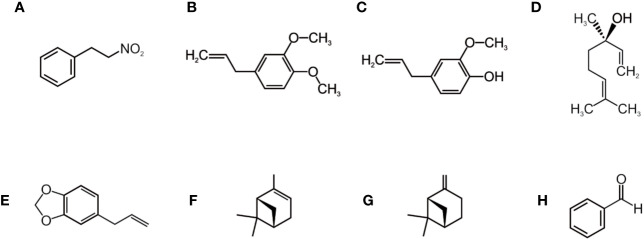
Substances present in the Aniba canelilla essential oil: 1-nitro-2-phenylethane (A), methyleugenol (B), eugenol (C), linalool (D), safrole (E), α-pinene (F), β-pinene (G), benzaldehyde (H). Adapted from: Sugimoto et al. (2017), Sipe et al. (2014), Tsuchiya (2017), Rianjanu et al. (2018), Silva et al. (2012).